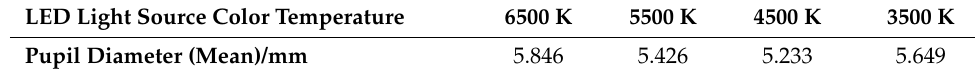
Table 11. LED light source color temperature and pupil diameter influence degree.